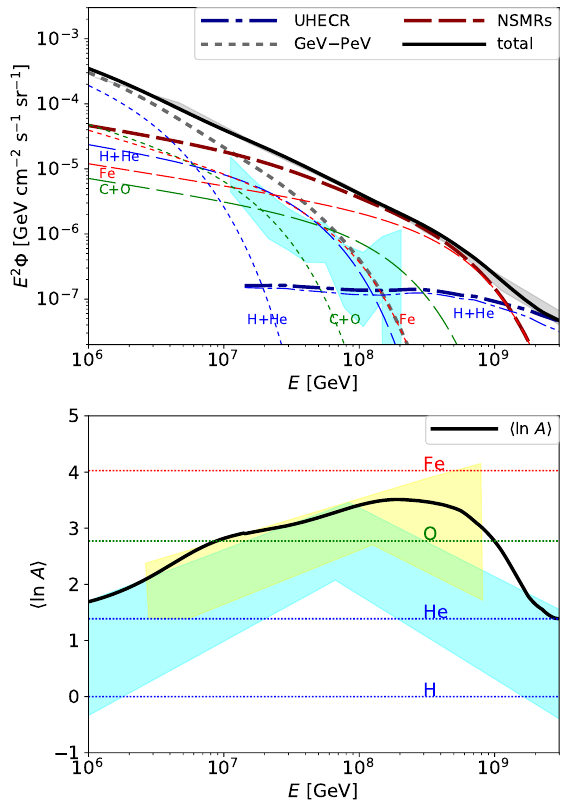
Figure 4. Upper panel: Cosmic-ray intensity from NSMRs (dashed line). We also plot the GeV-PeV component (dotted line) and extragalactic component (dot-dashed line: obtained from [82]). The gray band represents the experimental data [84, 86]. The cyan region shows the intensity of the light composition [85]. Lower panel: the mean atomic number of the cosmic rays on Earth. The solid line shows our model prediction. This is consis- tent with the experimental results (yellow [87] and cyan regions [88]), although uncertainty is large. This figure is reproduced from